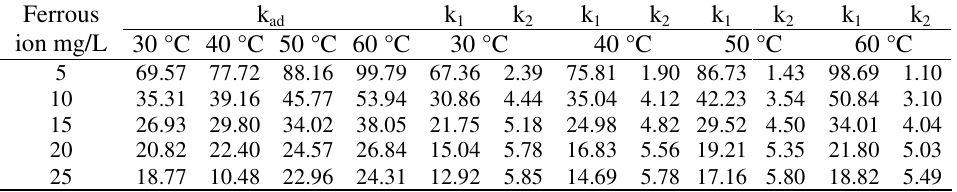
Table 7. Rate constants for the adsorption of ferrous ions (10 3 k for forward (10 3 k , min -1 ) and reverse (10 3 k 1